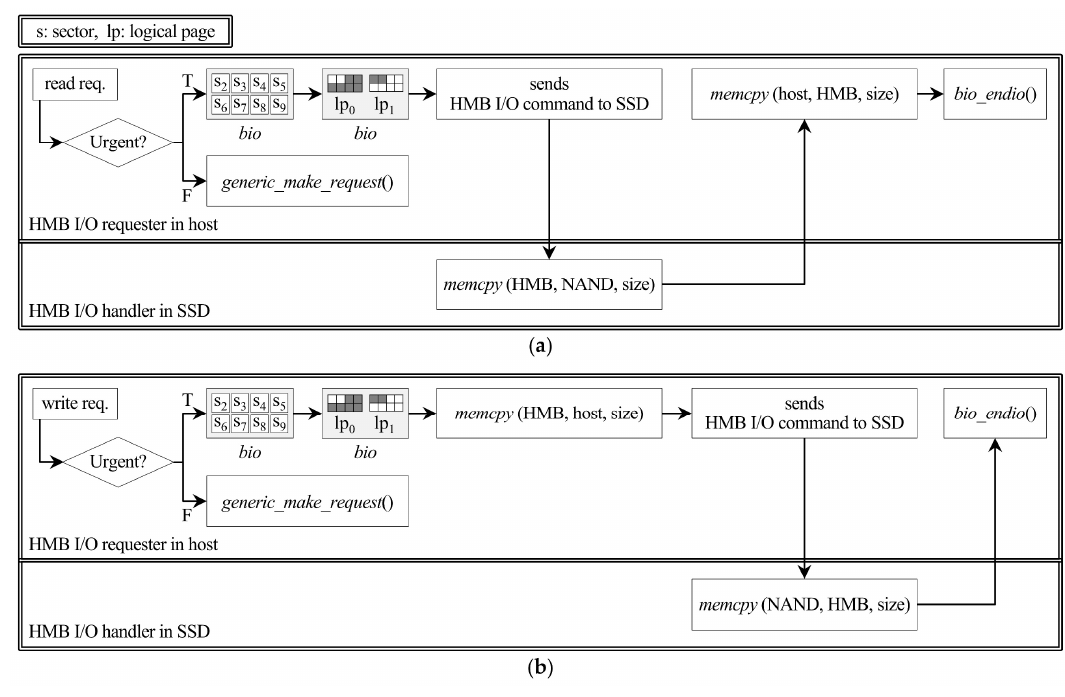
/ O procedures. ( a ) Read requests; ( b ) write Figure 5. HMB I/O procedures. ( a ) Read requests; ( b ) write requests. Figure 5. HMB I Figure 5. HMB I/O procedures. ( a ) Read requests; ( b ) write requests.